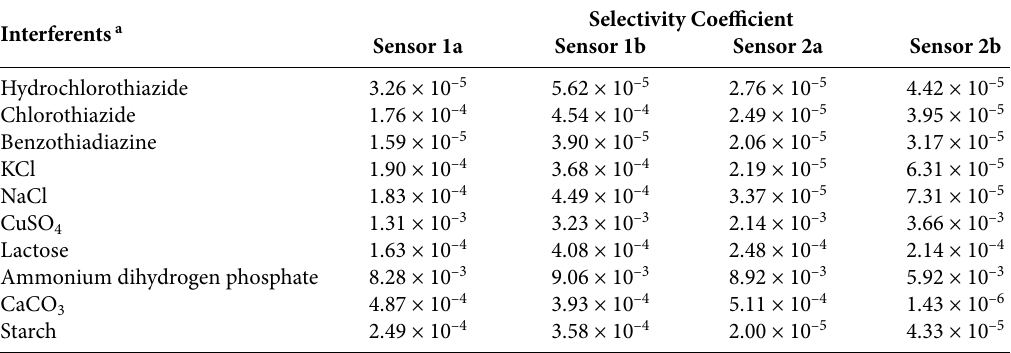
Table 2. Potentiometric selectivity coefficients of the proposed electrodes using a separate solution method. Interferents